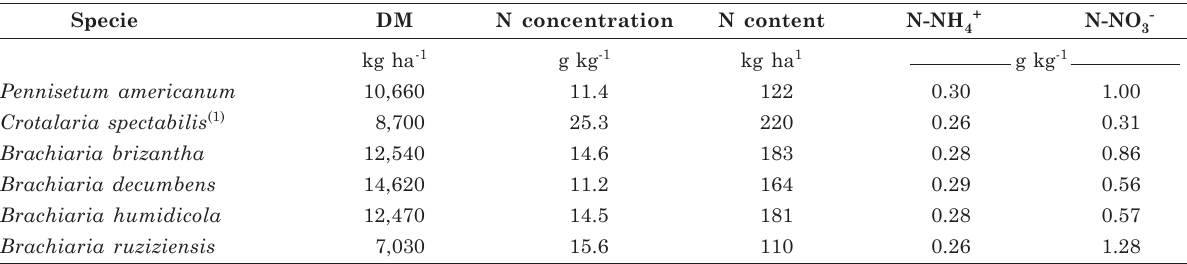
Table 1. Dry matter (DM), nitrogen (N) concentration and content, and ammonium (N-NH 4+ ) and nitrate (N-NO 3- ) concentration in cover crops before